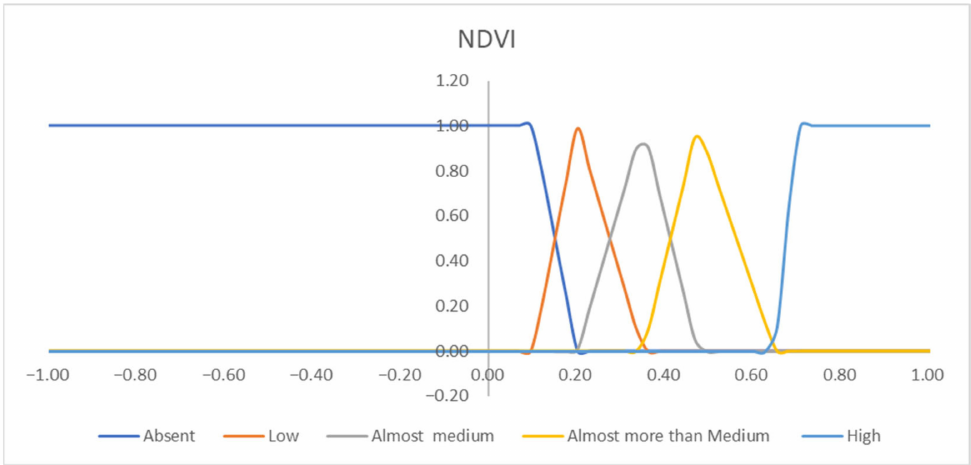
Figure 15. The thematic map of the NDVI index using fuzzy partition in Figure 14.